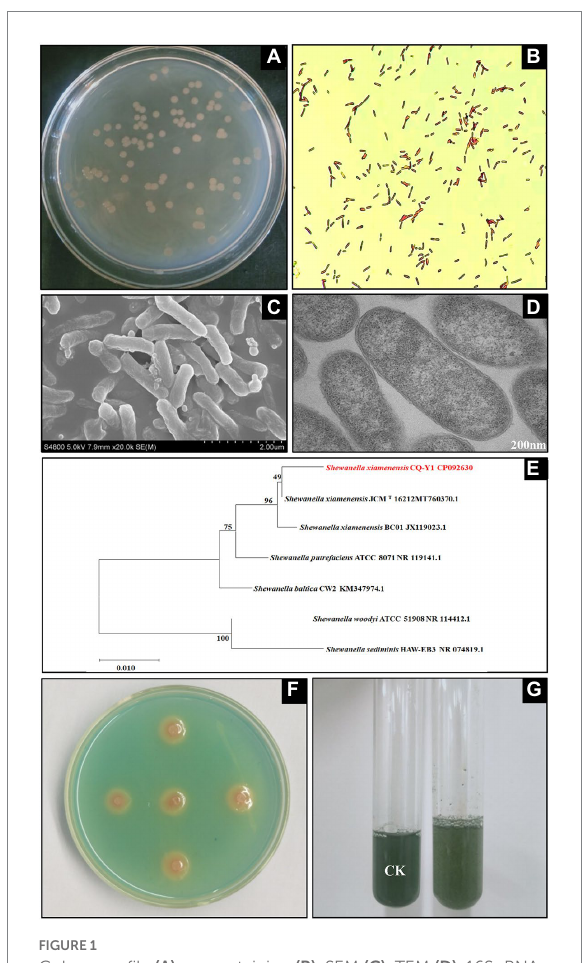
FIGURE 1 Colony profile (A) , gram staining (B) , SEM (C) , TEM (D) , 16S rRNA gene neighbor-joining phylogenetic tree (E) , qualitative (F) and quantitative (G) siderophores